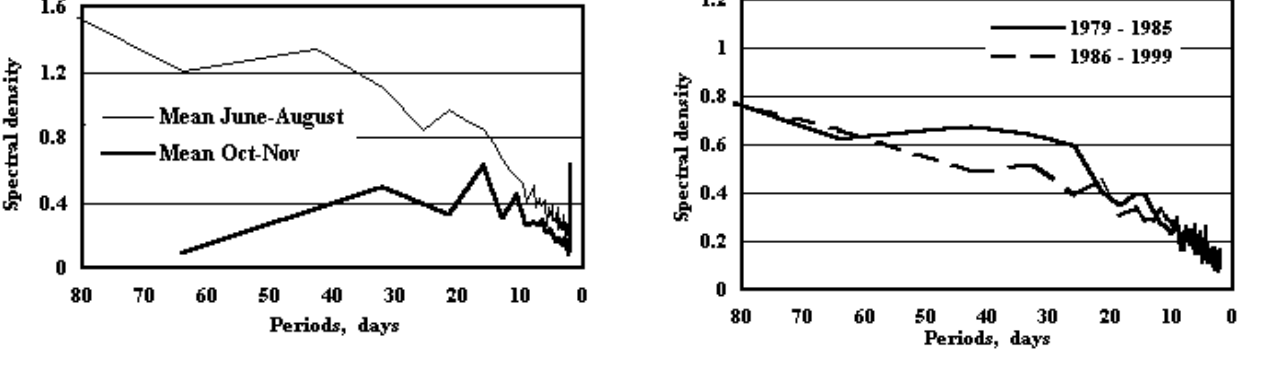
Fig. 4. Mean winter/spring power spectra of total ozone deviations for 1979–1985 and